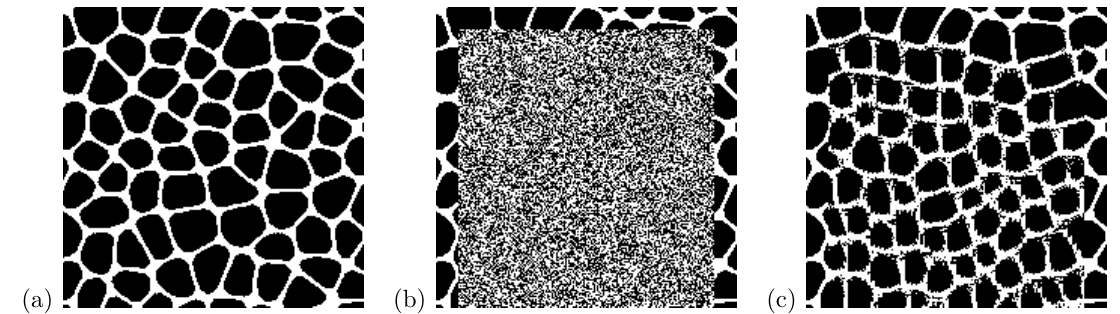
Figure 2. Microstructure reconstruction process using the causal model. After training the neural network model on input data from the initial microstructure (a), the trained model is used to sequentially predict pixel values in a raster scan order using previously predicted pixel values from the causal neighbourhood.